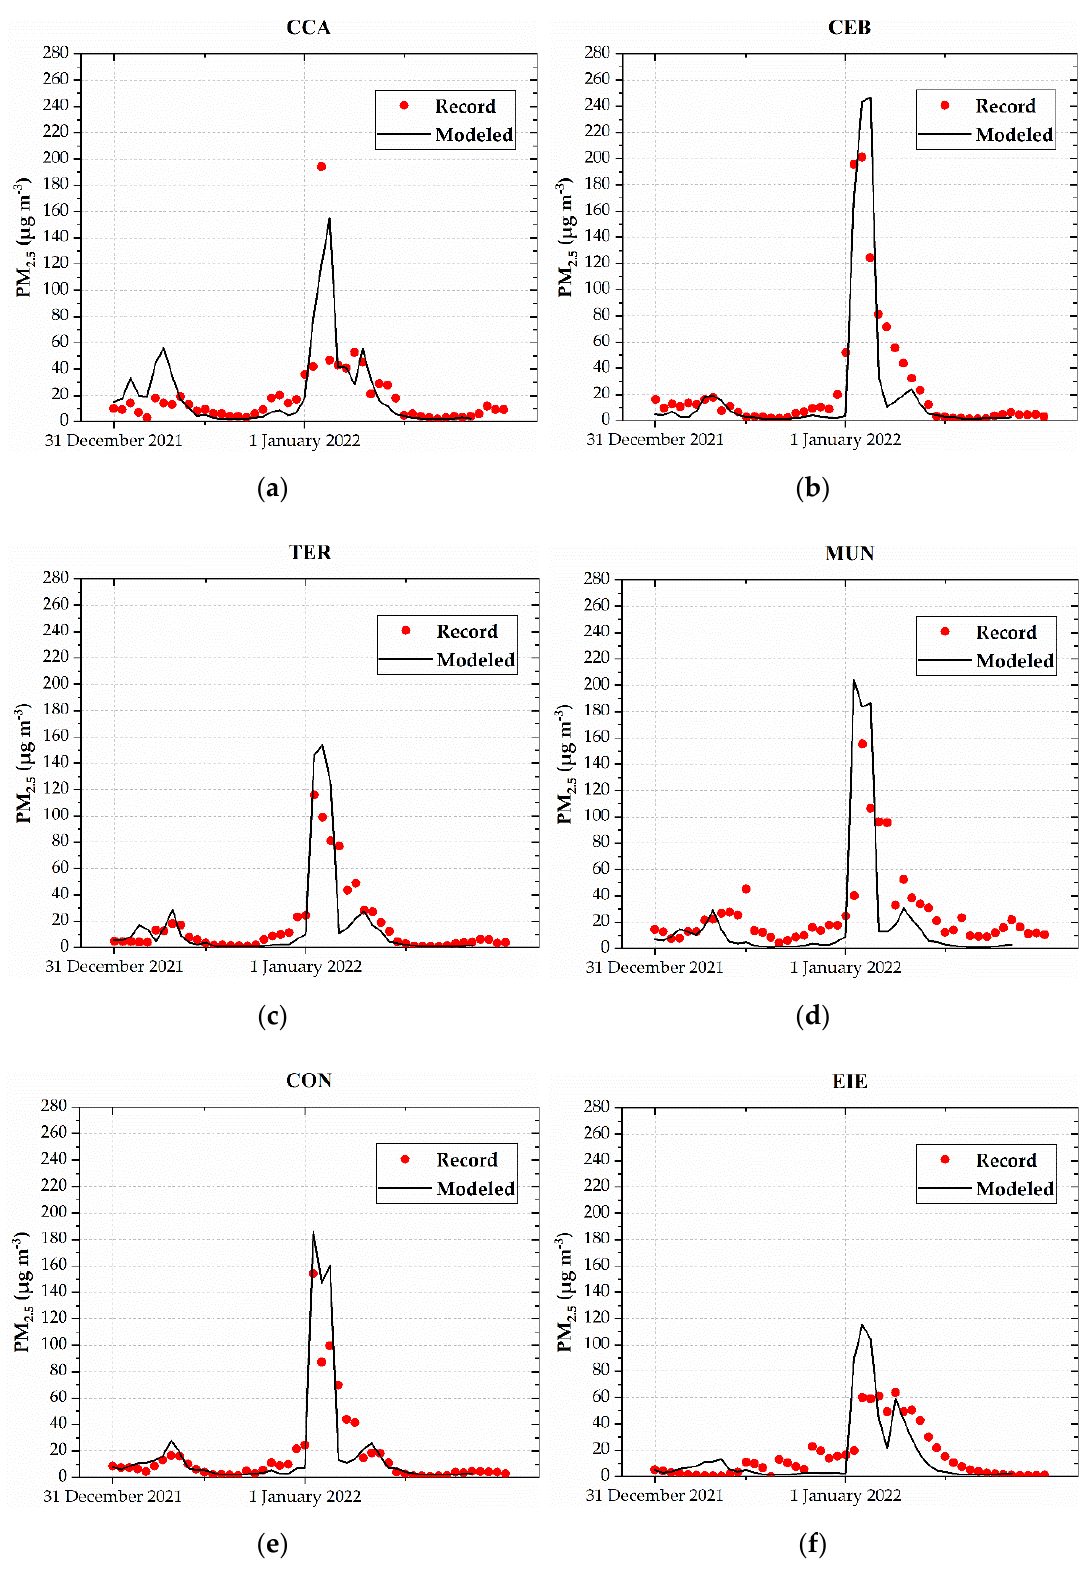
Figure 5. Hourly PM 2.5 records and modeled concentrations from 31 December 2021 to 1 January 2022: the ( a ) CCA, ( b ) CEB, ( c ) TER, ( d ) MUN, ( e ) CON, and ( f ) EIE stations.